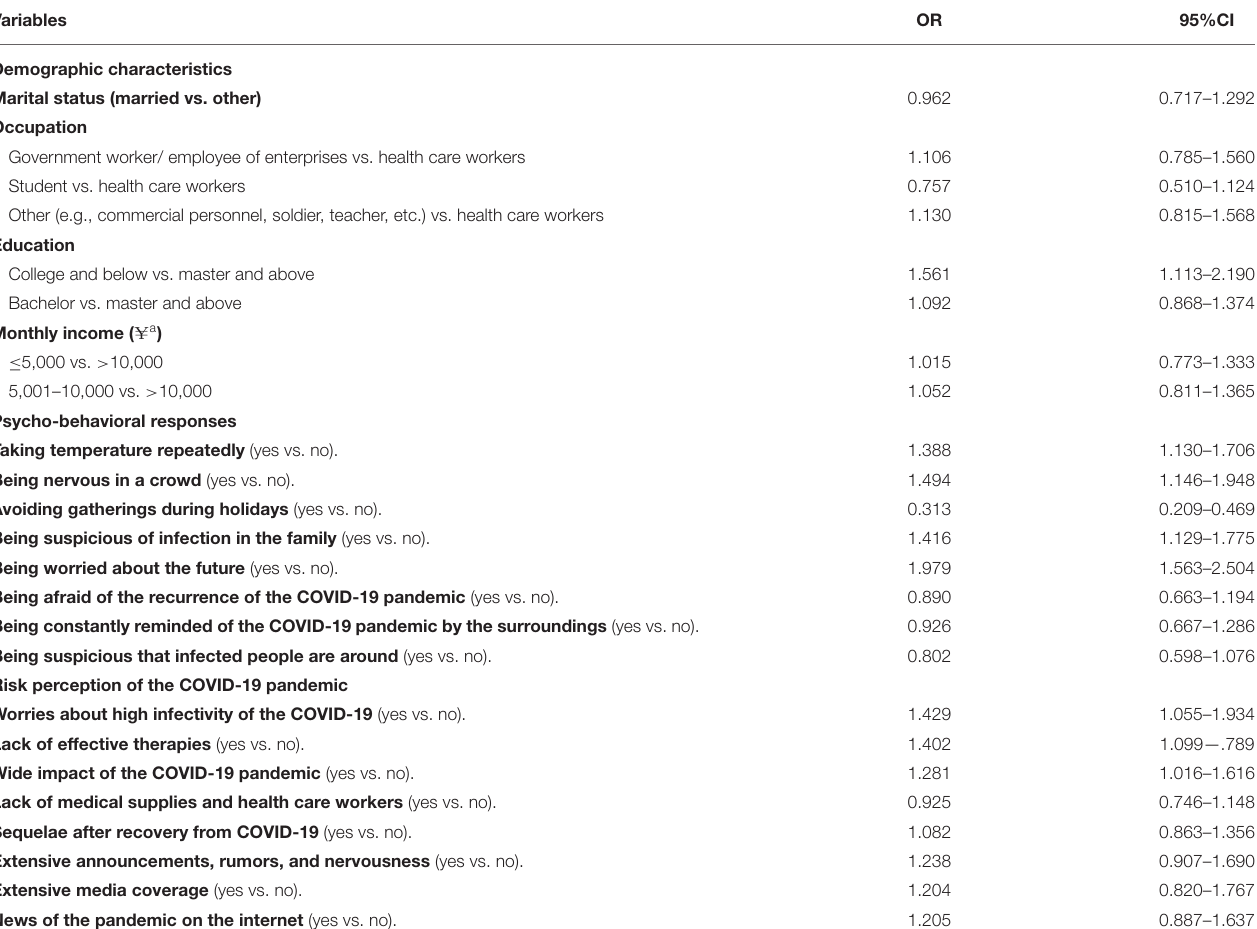
TABLE 2 | The multivariable logistic regression analysis.